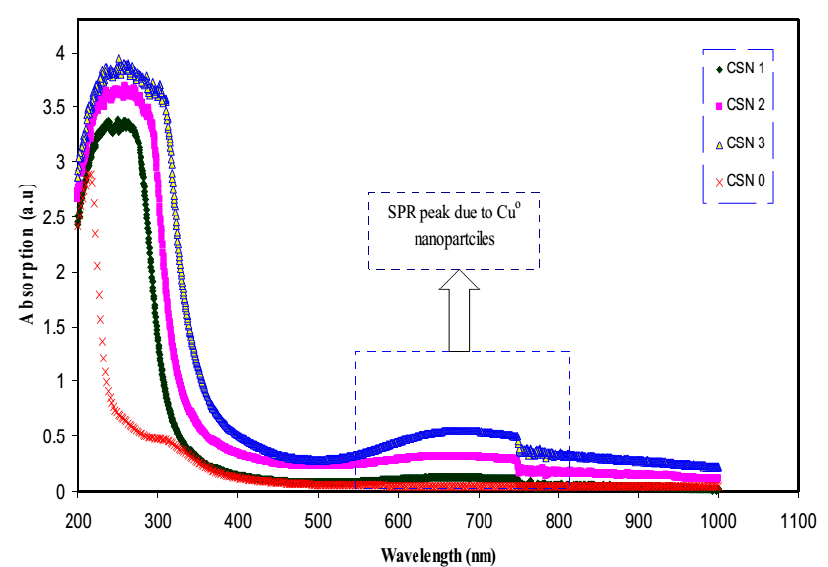
Figure 6. Absorption spectra of pure CS and CS/CuI solid electrolyte films. The surface plasmonic resonance (SPR) peak appearing at approximately 667 nm for CS/CuI samples is related to the existence of Cu metallic NPs [78].